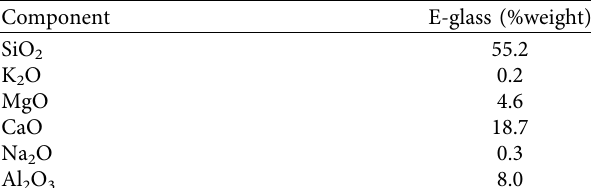
Table 3: Chemical composition of E-glass fiber.